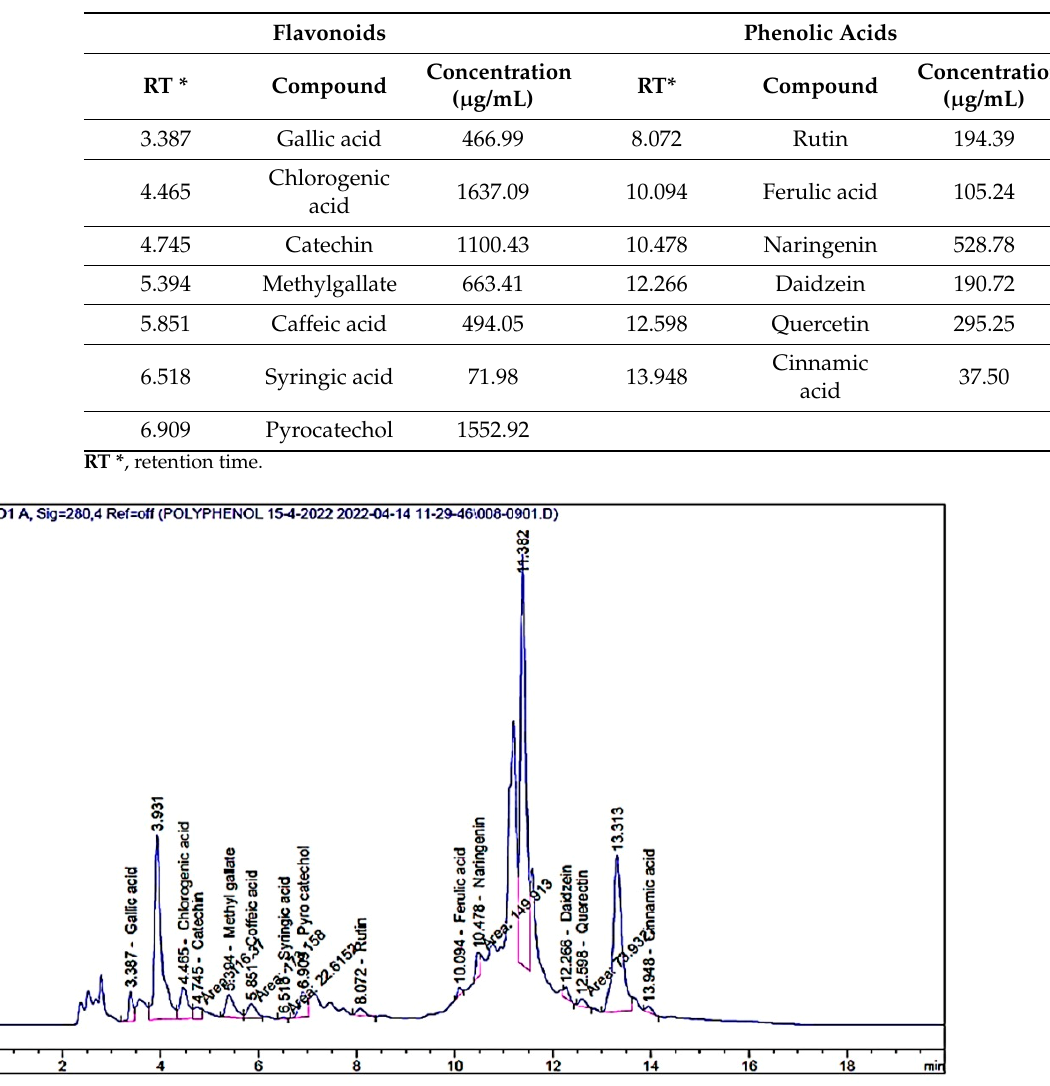
Table 1. Flavonoids and Phenolic acids content of M. pulegium extract identified by HPLC.